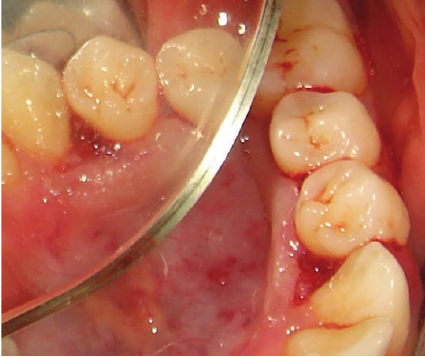
Figure 3: Incisional biopsy done on the lingual side.